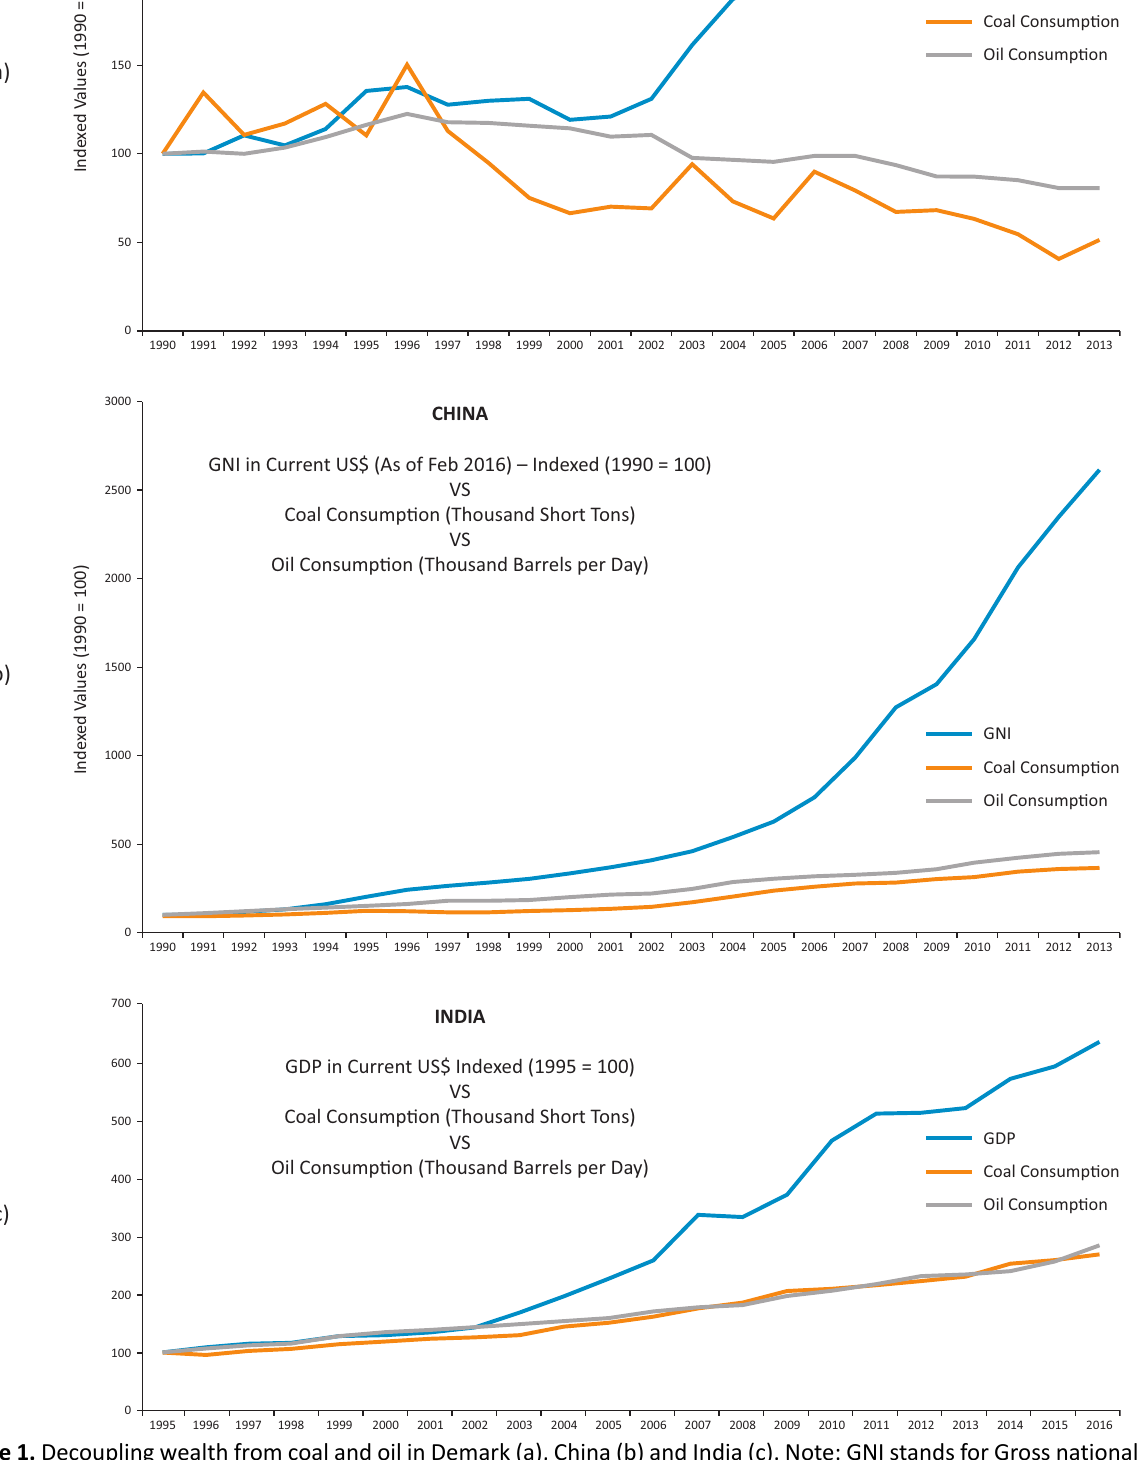
Figure 1. Decoupling wealth from coal and oil in Demark (a), China (b) and India (c). Note: GNI stands for Gross national in- come, which is almost equivalent to GDP but is more available in terms of data. Source: Compiled by author based on data sourced from CEID (2017), United States of America Energy Information Administration (EIA, 2016), Ministry of Petroleum & Natural Gas (2017), Newman (2017b), OPEC (2016) and The Worldbank Group (WBG,